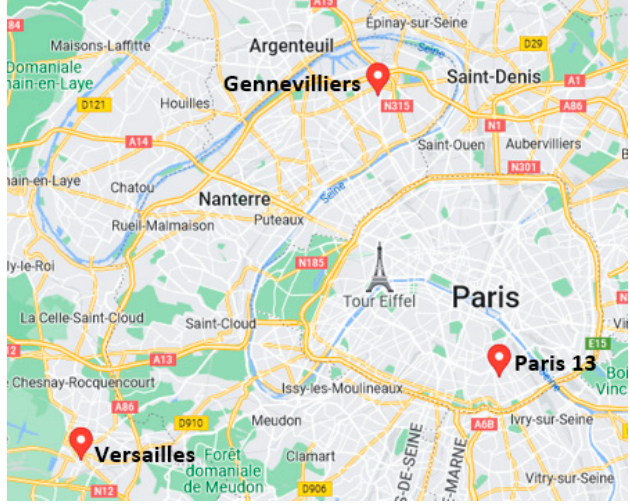
Figure 2. Maps of Airparif stations .